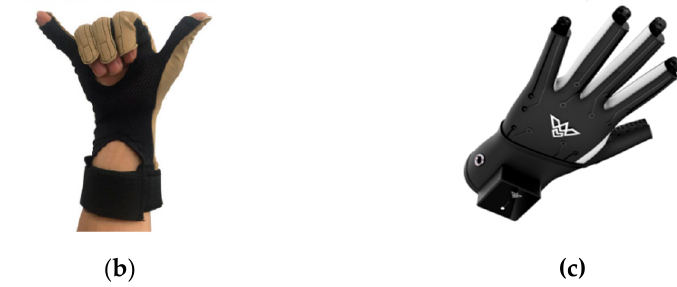
Figure 4. Commercial data gloves for gesture recognition: ( a ) MoCap Pro Glove [132]; ( b ) Cyber Glove [133]; ( c ) Vrtrix Glove [134].